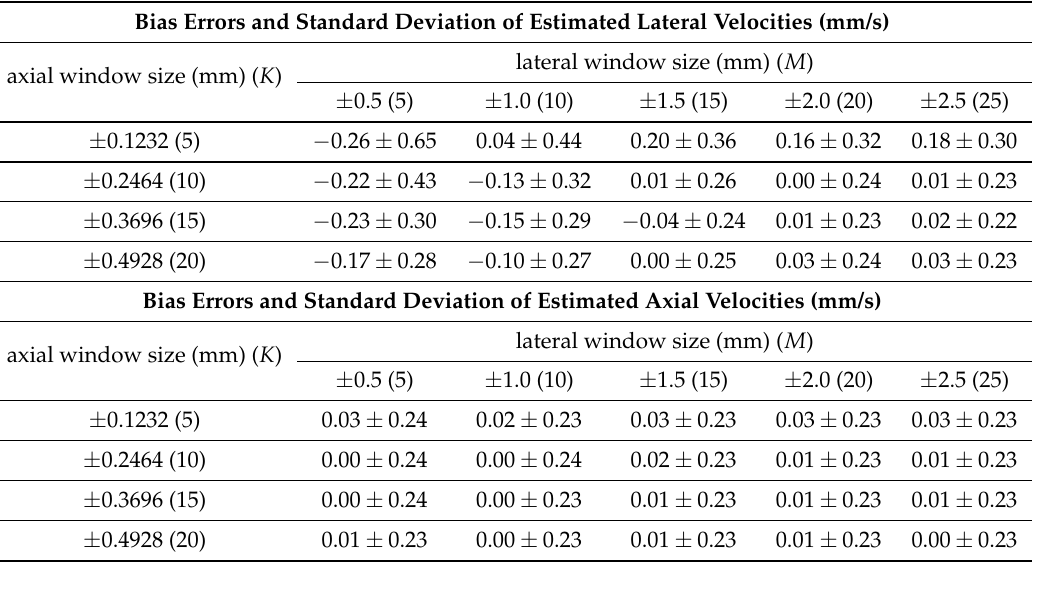
Table 1. Bias errors e bias and standard deviations σ of lateral and axial displacements at nine red points in Figure 4a estimated by the conventional 2D motion estimator without frame averaging. Beamformed echo signals were obtained with rectangular apodization. Actual lateral and axial velocities were 2 mm/s and –1 mm/s, respectively.